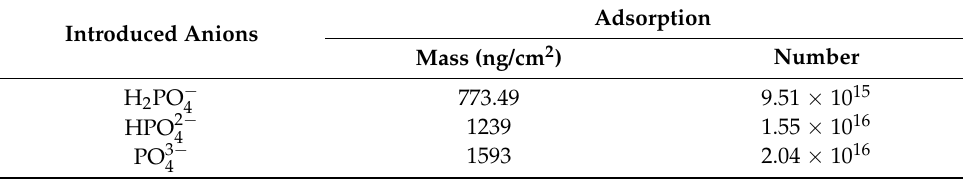
Figure 2. Adsorption behavior of salt ions measured using the QCM: ( a ) NaH 2 PO 4 , ( b ) Na 2 HPO 4 , and ( c ) Na 3 PO 4 . and ( c ) Na 3 PO 4 . Table 1. Adsorption results of anions with different charges. Table 1. Adsorption results of anions with different